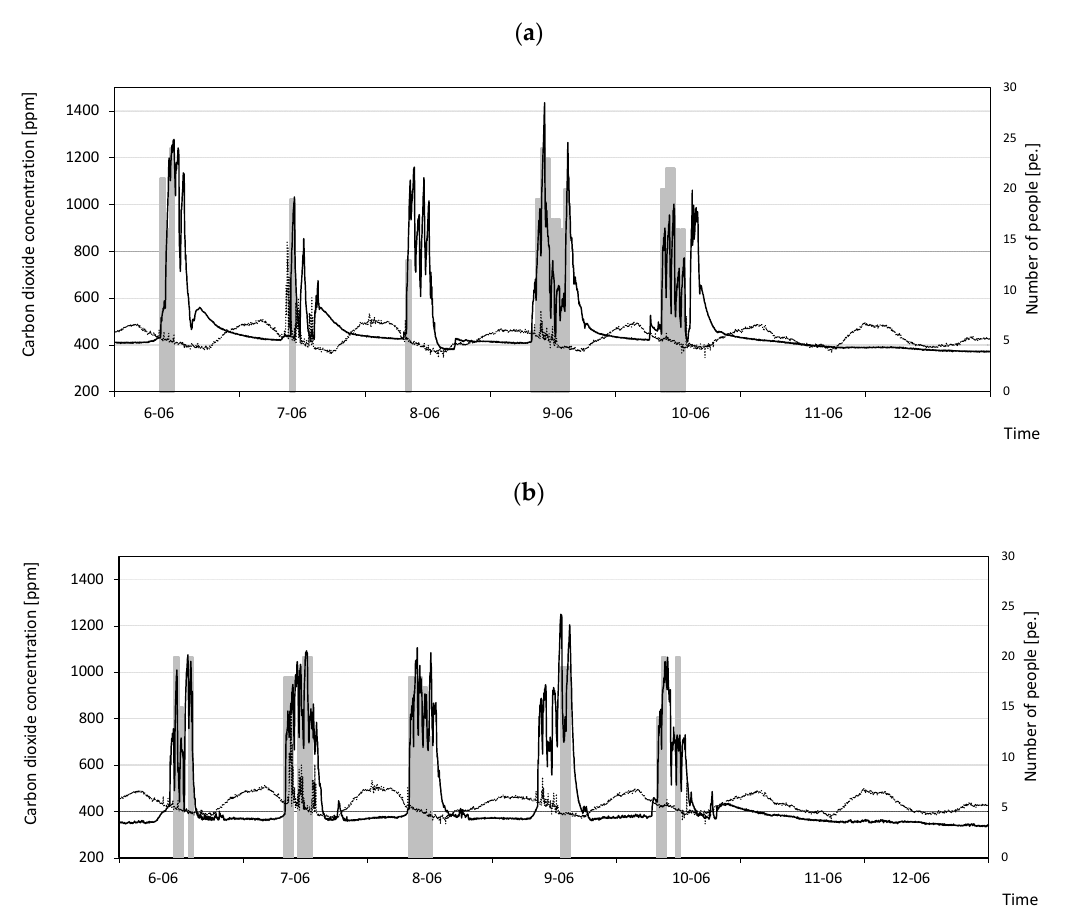
Figure 1. Variability of carbon dioxide concentrations in the week from 6th to 12th June, ( a ) in classroom 04, ( b ) in classroom 105.